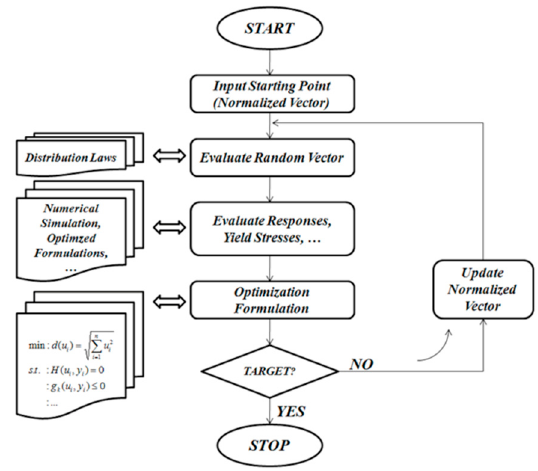
Figure 6. Flowchart of developed reliability algorithm.